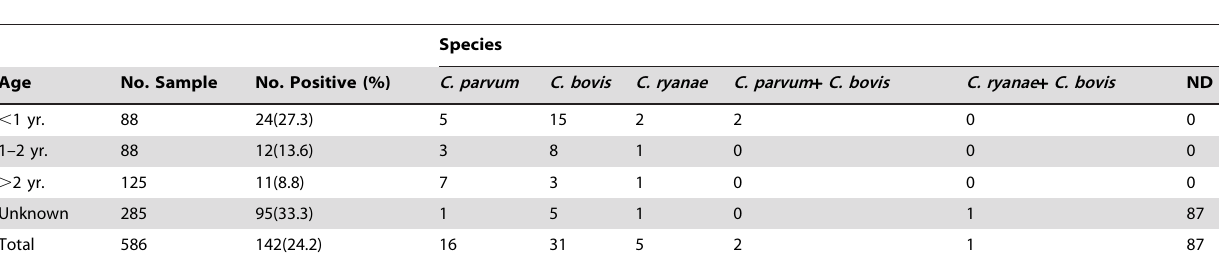
Table 3. Prevalence and molecular characterization of Cryptosporidium spp. in different host age groups.